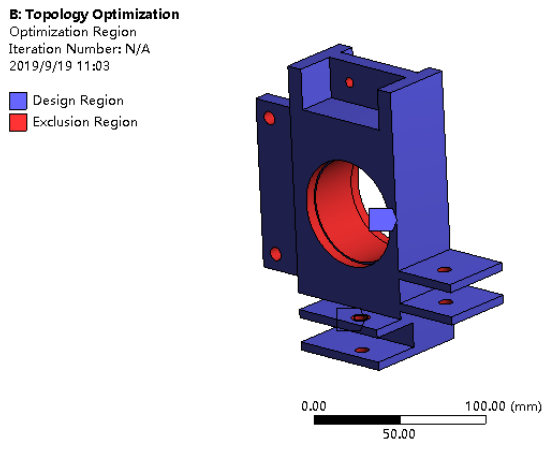
Figure 6. Topology optimization area.